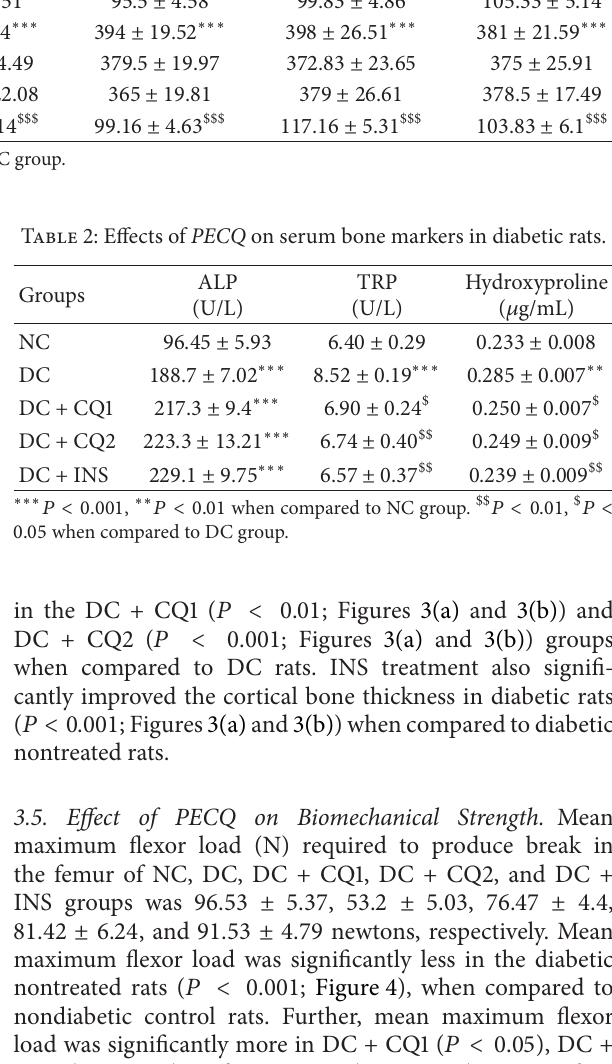
Table 1: Effect of PECQ on blood glucose levels (mg/dL) in diabetic rats. Groups